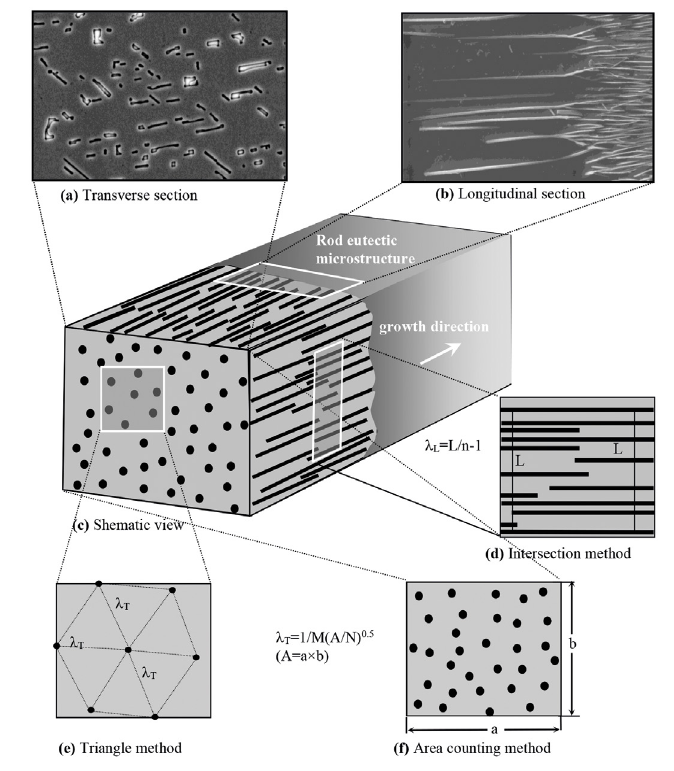
Fig. 3. The shematic illustration of rod spacings measurements from the longitudinal and transverse Sections longitudinal section. Two different methods were used to measure the rod spacings on the transverse sections. The first method is the triangle method 16 . The triangle is formed by joining the three neighbouring rod centers, and each sides of the triangle corresponded to λ . The second method is the area counting method 17 . The rod spacings measured on